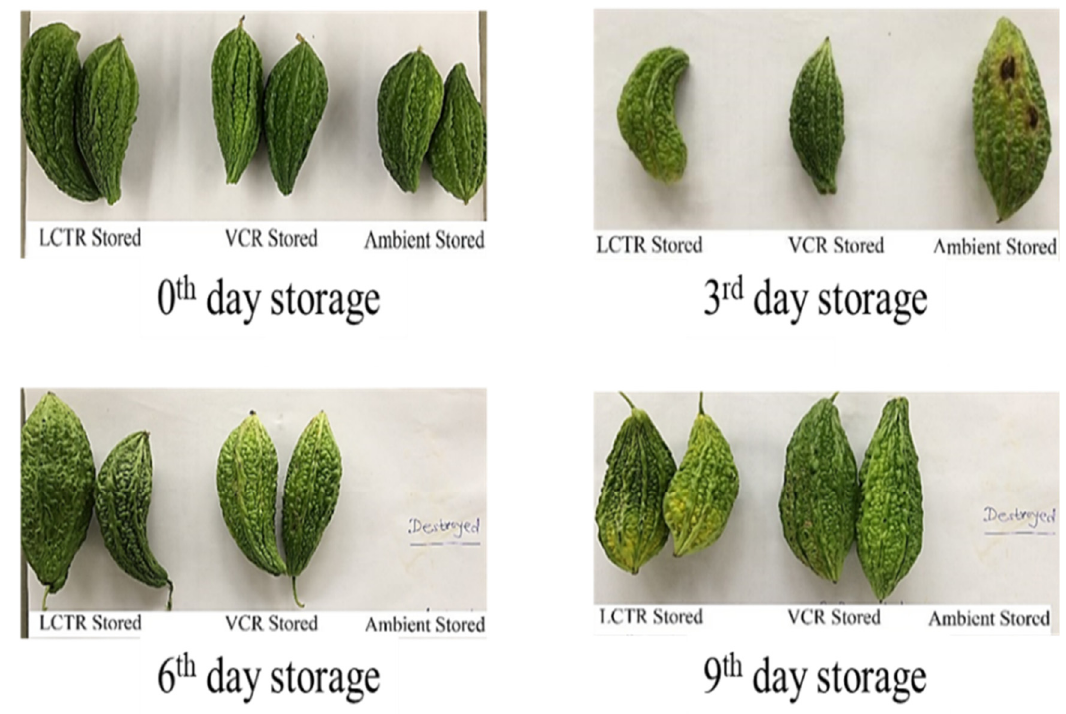
Figure 6. Effect of storage system on the visual appearance of bitter gourd.